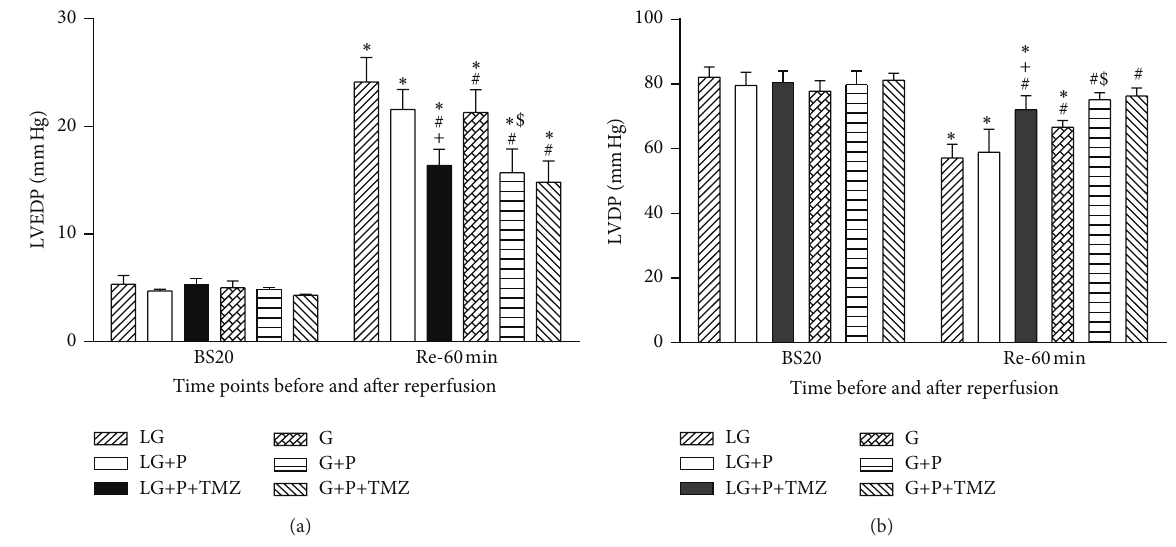
Figure 2: Effect of low glucose (LG) and glucose (G) on left ventricular end-diastolic pressure (LVEDP) and left ventricle developed pressure (LVDP) during ischemia reperfusion. LVEDP is not only a marker of diastolic function but also a good predictor of cardiac mortality independent of LV ejection fraction. LVDP was calculated by subtracing LVEDP, from LV peak systolic pressure (LVSP). There was significantly increase in LVEDP and decrease in LVDP in LG as compared to G (all 𝑃 < 0.05 ). Propofol significantly improved cardiac function in G but not in LG. TMZ facilitated propofol cardioprotection in LG. Values are presented as mean ± SEM. 𝑁 = 7 per group. ∗ 𝑃 < 0.05 versus BS20; # 𝑃 < 0.05 versus LG; + 𝑃 < 0.05 versus LG+P; $ 𝑃 < 0.05 versus G.